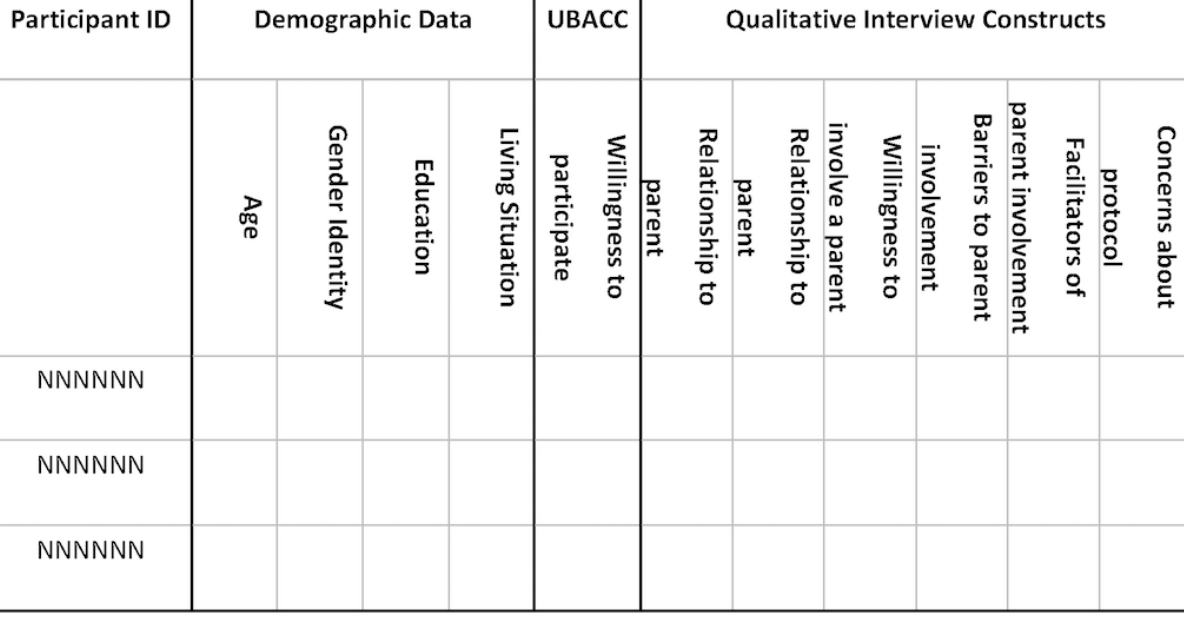
Figure 1. A sample qualitative data analysis matrix for adolescent participants. UBACC: University of California, San Diego Brief Assessment of Capacity to